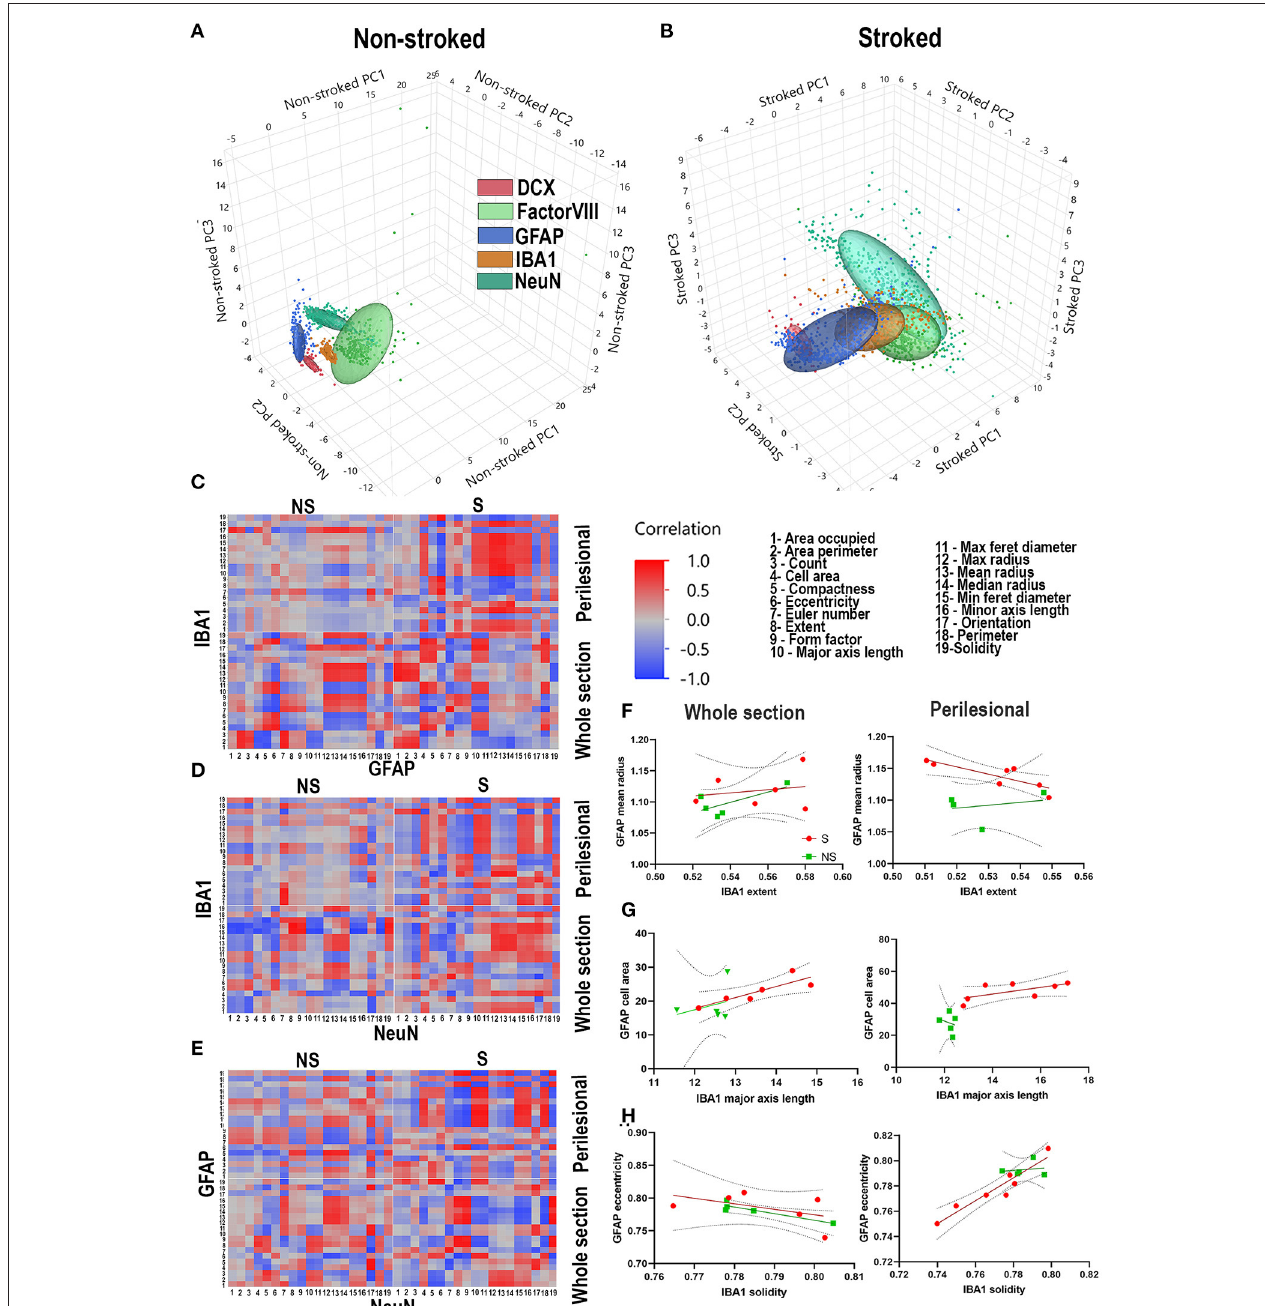
FIGURE 10 | Stroke alters relationship of morphological parameters across cell types. PCA of NS and S ROIs labeled by DCX (red), FactorVIII (light green), GFAP (dark blue), IBA1 (tan), and NeuN (dark green). PCA ellipses for each stain are well-delineated in NS animals (A) , but not in S animals (B) . Heatmaps of each parameter measured 1-19 were generated for GFAP vs. IBA1 (C) , IBA1 vs. NeuN (D) , and NeuN vs. GFAP (E) for each treatment group (S and NS) as well as each ROI location (perilesional or hemispheric section). NS animals generally showed an increase in strength of correlations, positively or negatively, when comparing heatmaps of perilesional areas and hemispheric section areas. In S animals, there often was a complete reversal of correlation directionality between perilesional and hemispheric sections (C–E) . Linear correlations, representative of one square of the heatmap showed significant correlations of perilesional IBA1 extent and GFAP mean radius in S ( p = 0.0220) but not NS animals ( p = 0.6779) (F) ; in hemispheric section IBA1 major axis length and GFAP cell area in S animals ( p = 0.0289), but not NS animals ( p = 0.6402); in hemispheric section ROIs of GFAP eccentricity and IBA1 solidity in NS animals ( p = 0.0311), but not S animals ( p = 0.3103) (G) ; and in perilesional GFAP eccentricity and IBA1 solidity in S animals ( p = 0.0011), but not NS animals ( p = 0.7858) (H) .